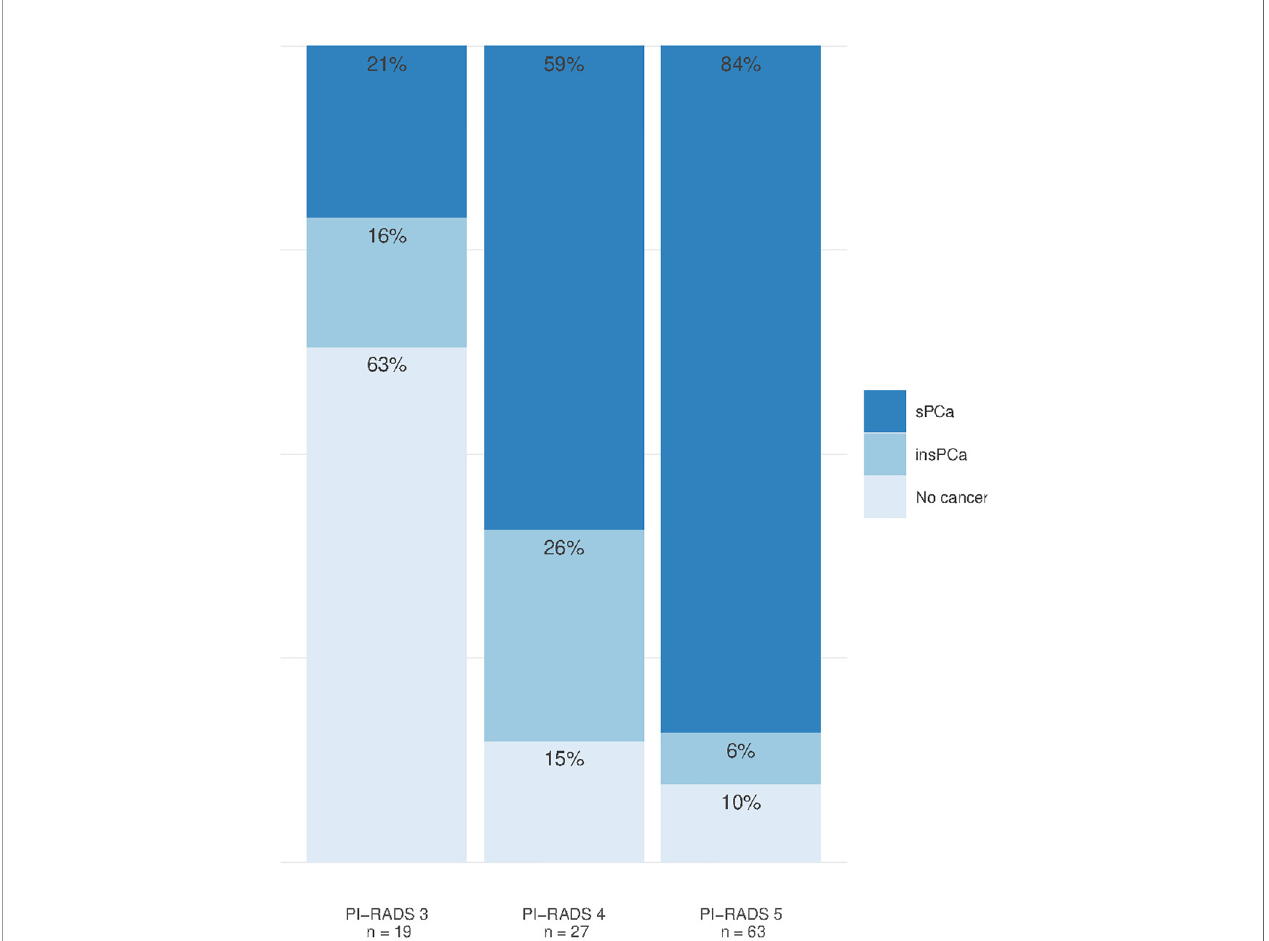
FIGURE 2 | Outcome after any biopsy in men with positive mpMRI (PI-RADS 3 – 5). sPCa, signi fi cant prostate cancer; insPCa, insigni fi cant prostate